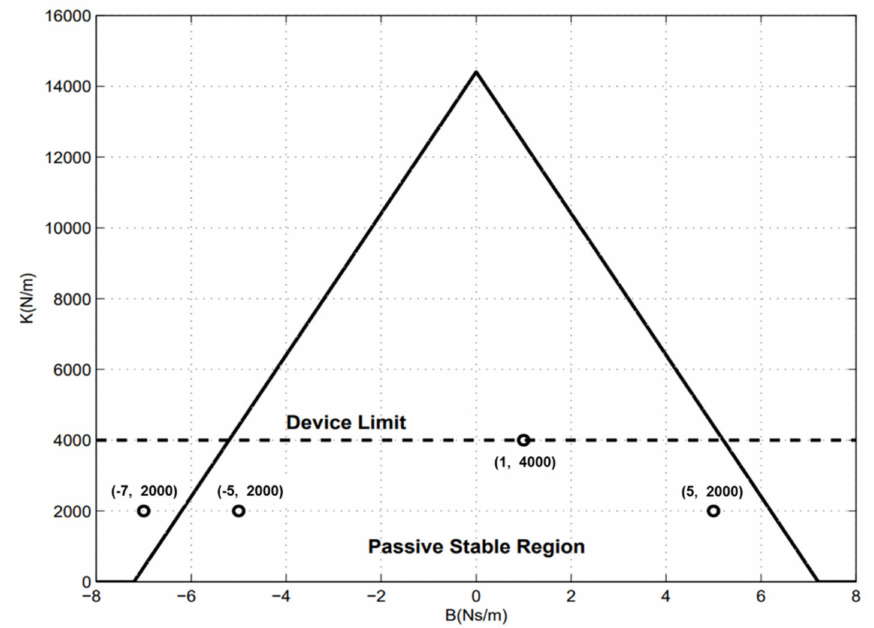
Figure 4. Region of passive